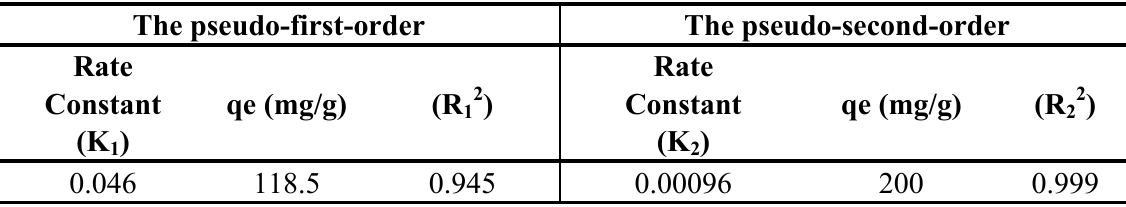
Table 2. Kinetic constants for cadmium (II) adsorption onto maleic acid-treated Tamrix articulata wastes at an initial concentration of 400 mg/L at 30 °C and pH